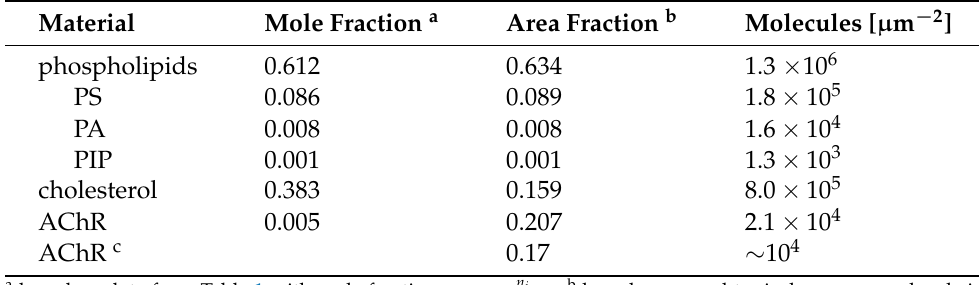
a based on data from Table 1 with mole fraction χ bilayer ( a PL ≈ 0.5nm 2 [63], a CHOL ≈ 0.2nm 2 [63] and a AChR ≈ 10nm 2 [64]) with area fraction Γ i = A i